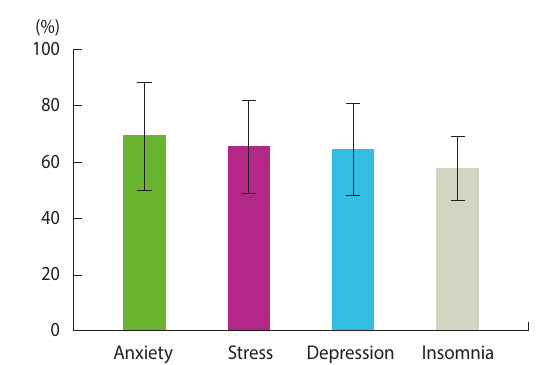
Figure 2. The prevalence of psychiatric disorders represented by the event rate and corresponding 95% confidence interval.